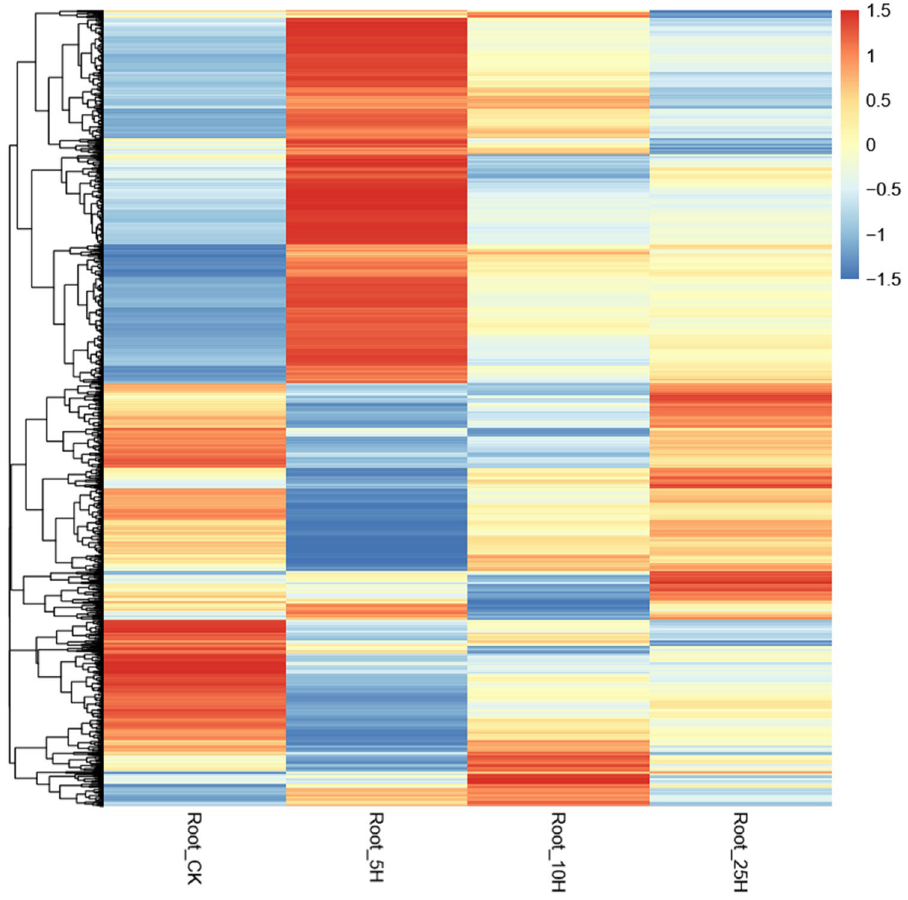
Figure 4. Heatmap for the expression of the identified DE transcripts in the four banana root lncRNA libraries clustered by log 10 (FPKM + 1) value. DE: differentially expressed. FPKM: fragments per kilobase million. Root_ CK, Root_5H, Root_10H and Root_25H is for the lncRNA library that roots were inoculated with Foc TR4 for 0 h, 5 h, 10 h and 25 h,